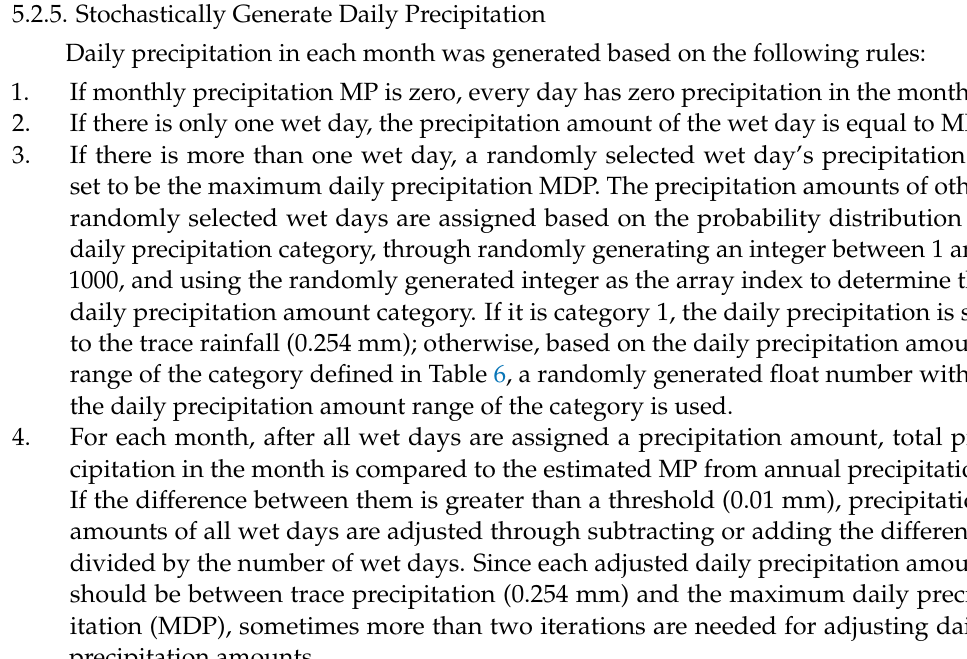
Figure 13. Probability distribution of the 11 categories of daily precipitation amount in each